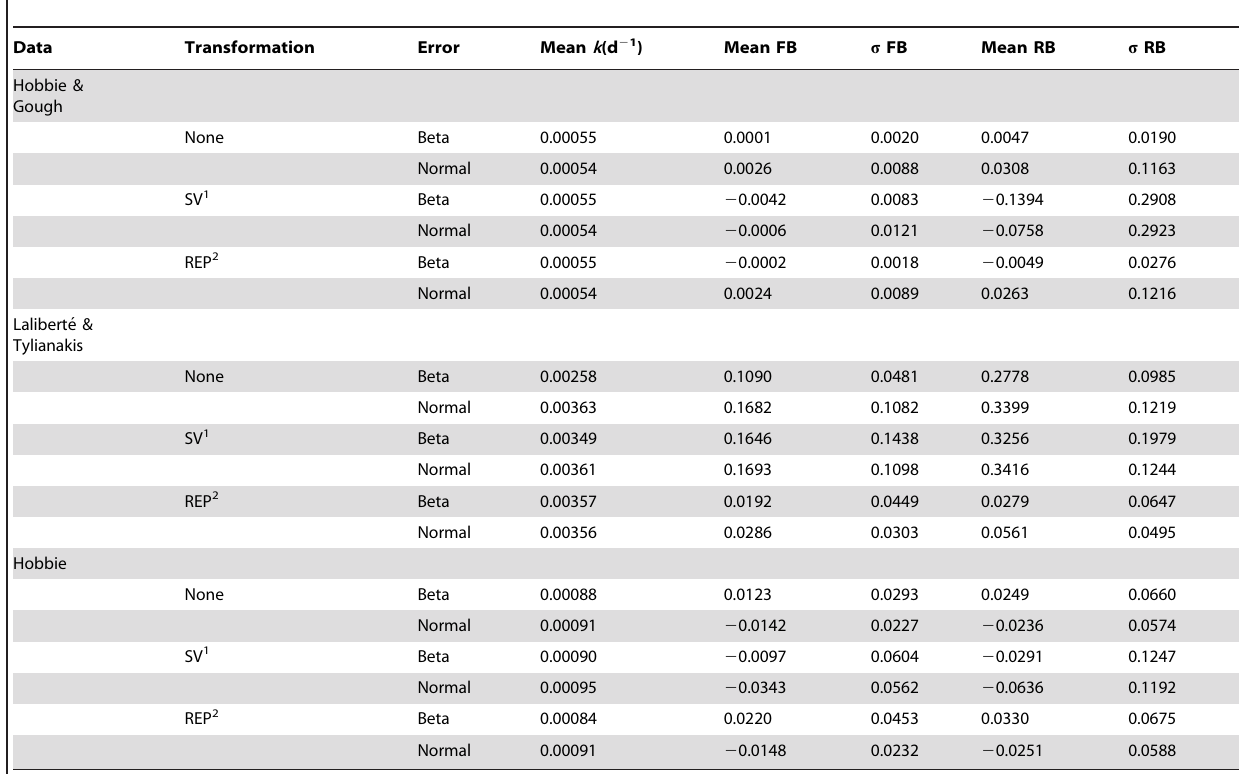
Table 7. Mean k (decomposition rate), fractional bias (FB) and relative bias (RB) produced by each data transformation and error structure using the Hobbie [14], Laliberte´ and Tylianakis [12] and Hobbie and Gough [10] data sets.